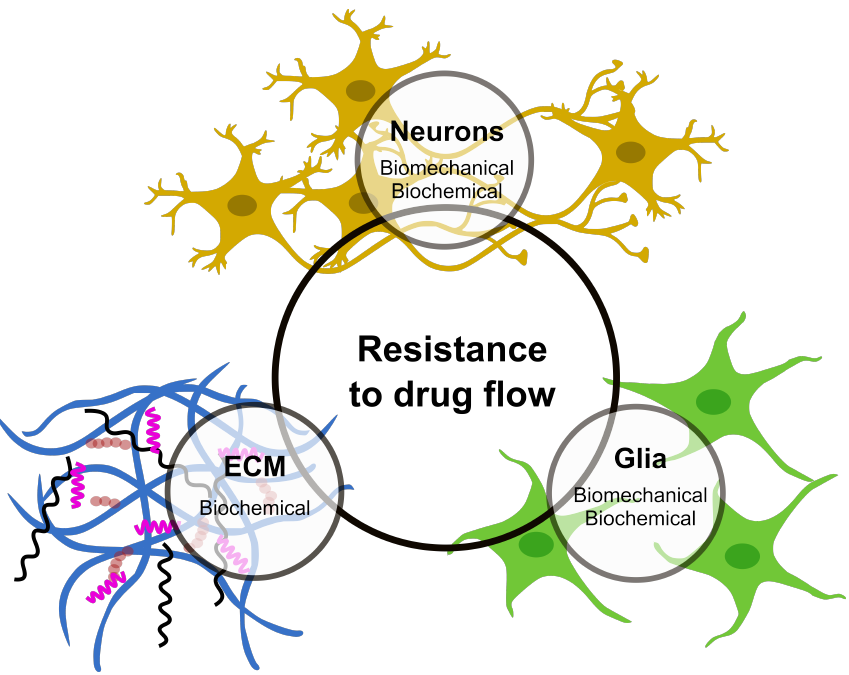
Figure 1. The CNS components that offer major resistance to drug flow and